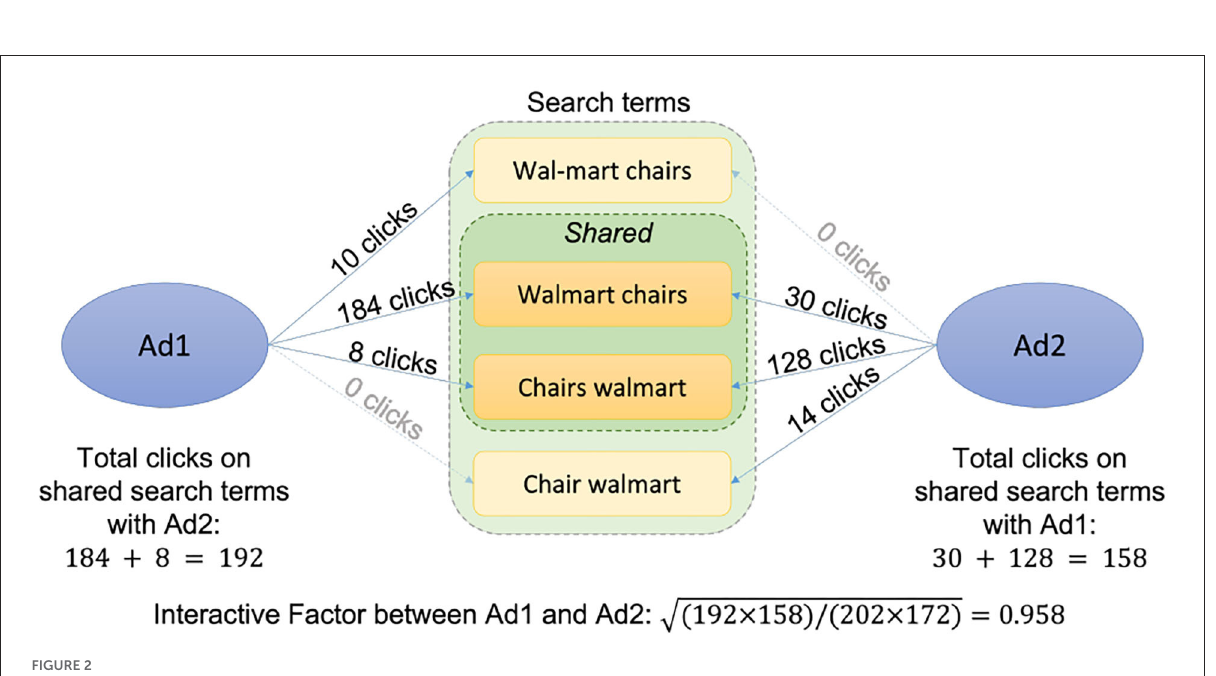
Refer to Figure 2 for an illustration of interactive metric in a real-world example, which effectively discounts the popularity and exposure